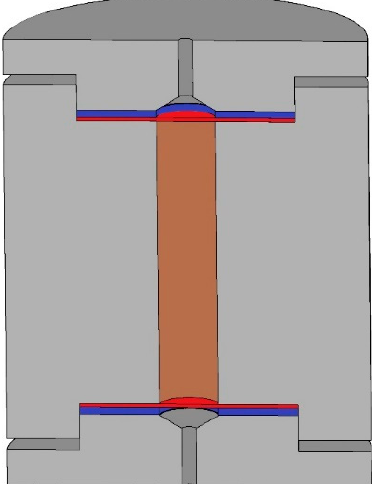
Figure 1. Cross-section of microcolumn: (gray); polytetrafluoroethylene (PTFE) column with screw Figure 1. Cross ‐ section of microcolumn: (gray); polytetrafluoroethylene ( PTFE ） column with screw caps, (blue); silicone spacers, (red)—membrane filters, (brown)—soil sample. caps, (blue); silicone spacers, (red) – membrane filters, (brown) – soil sample.